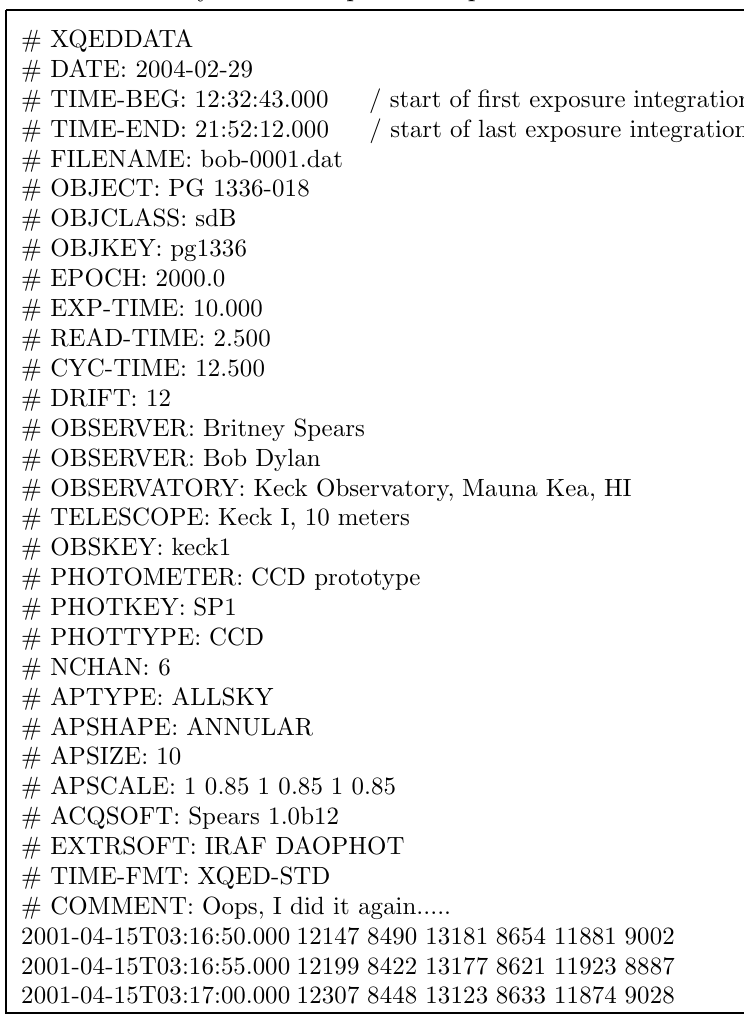
Table 6. An imaginary CCD data file, using many of the keyword concepts